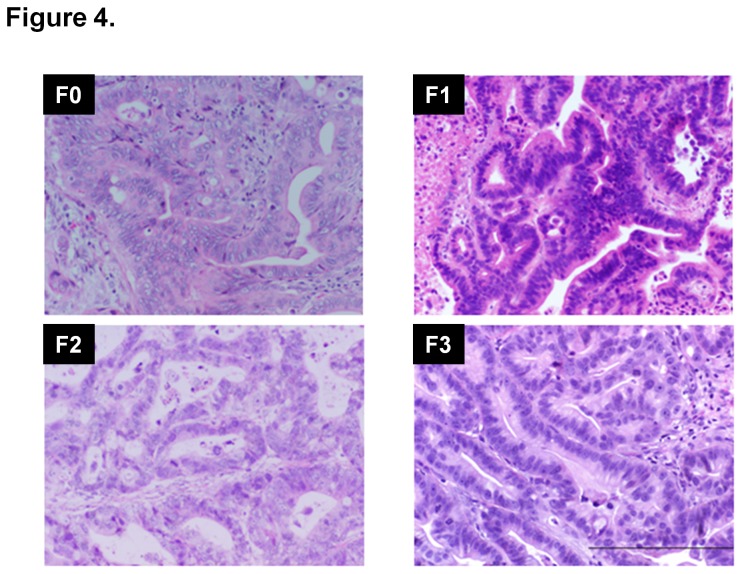
Three generations of tumorgraft UAB-PA2 retain morphology similar to that of the primary tumor.UAB-PA2 tumor was serially passaged to the third generation (F3), and the morphology of H&E stained sections of tumors compared. The Results section contains details of histological analyses.